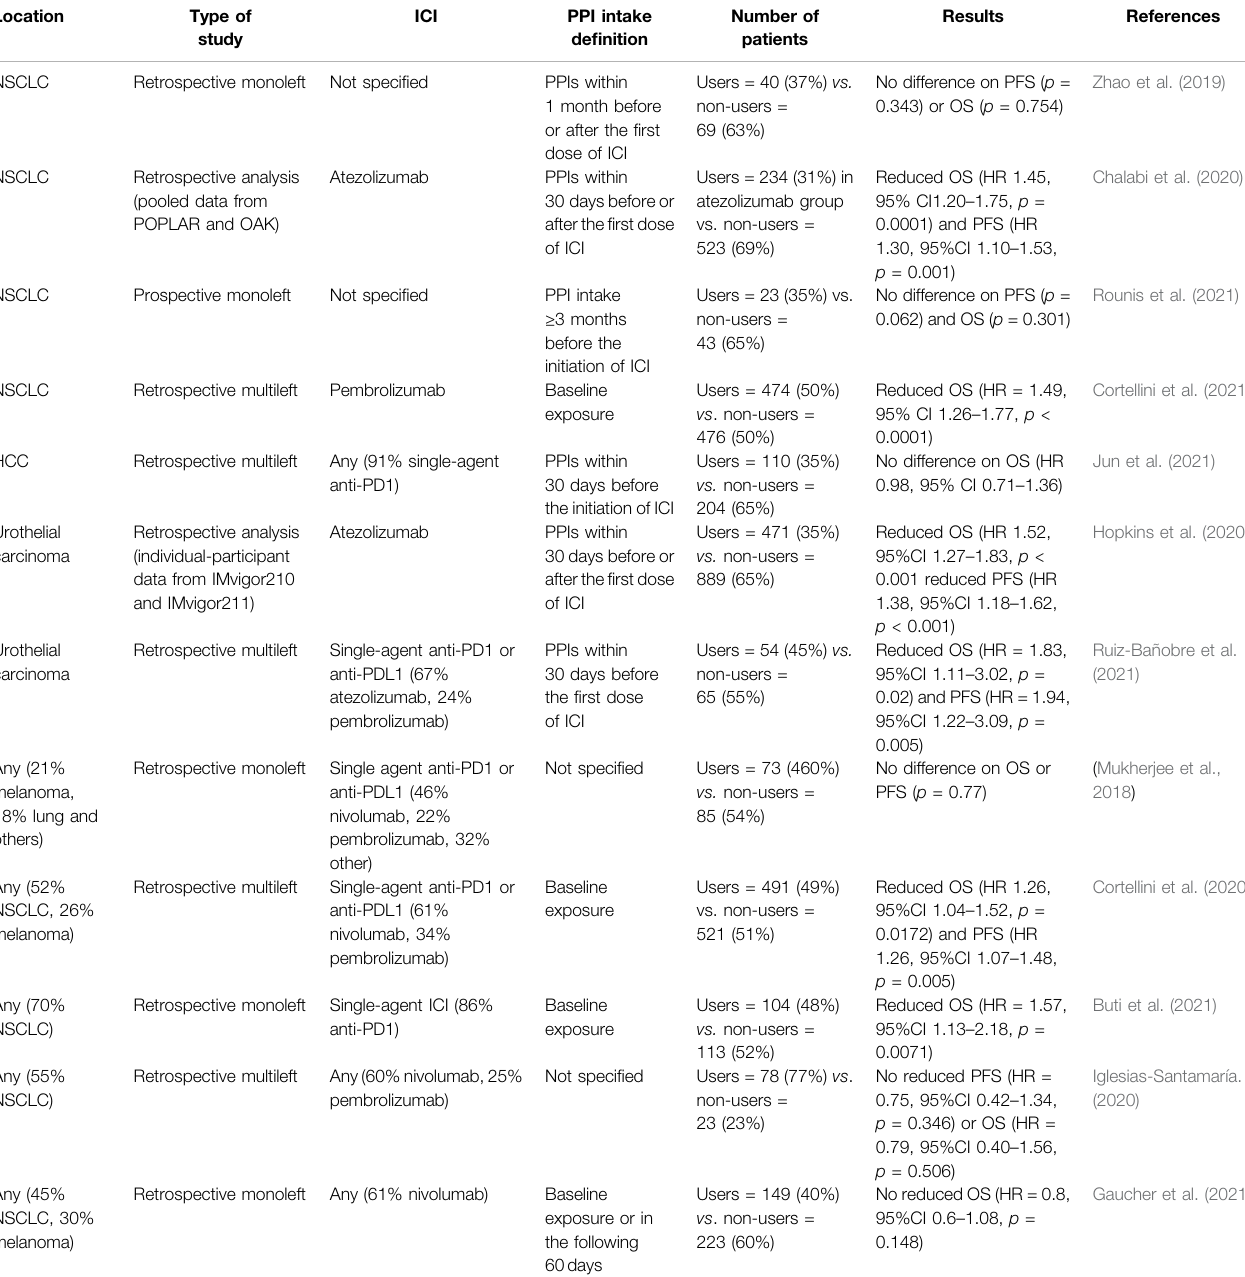
TABLE 5 | Main studies on interaction between immune checkpoint inhibitors and co-medication with proton pump